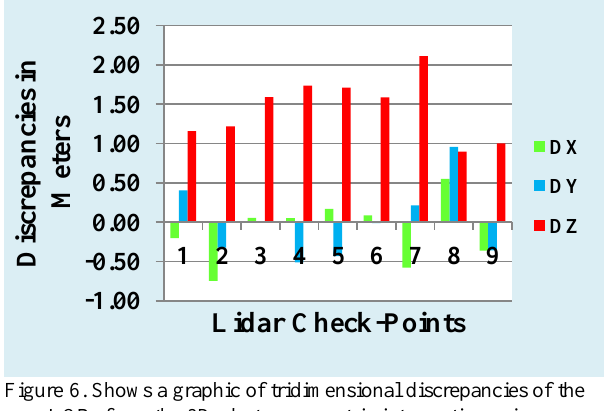
Figure 6. Shows a graphic of tridimensional discrepancies of the LCPs from the 3D photogrammetric intersection using unrefined IOP and EOPs.